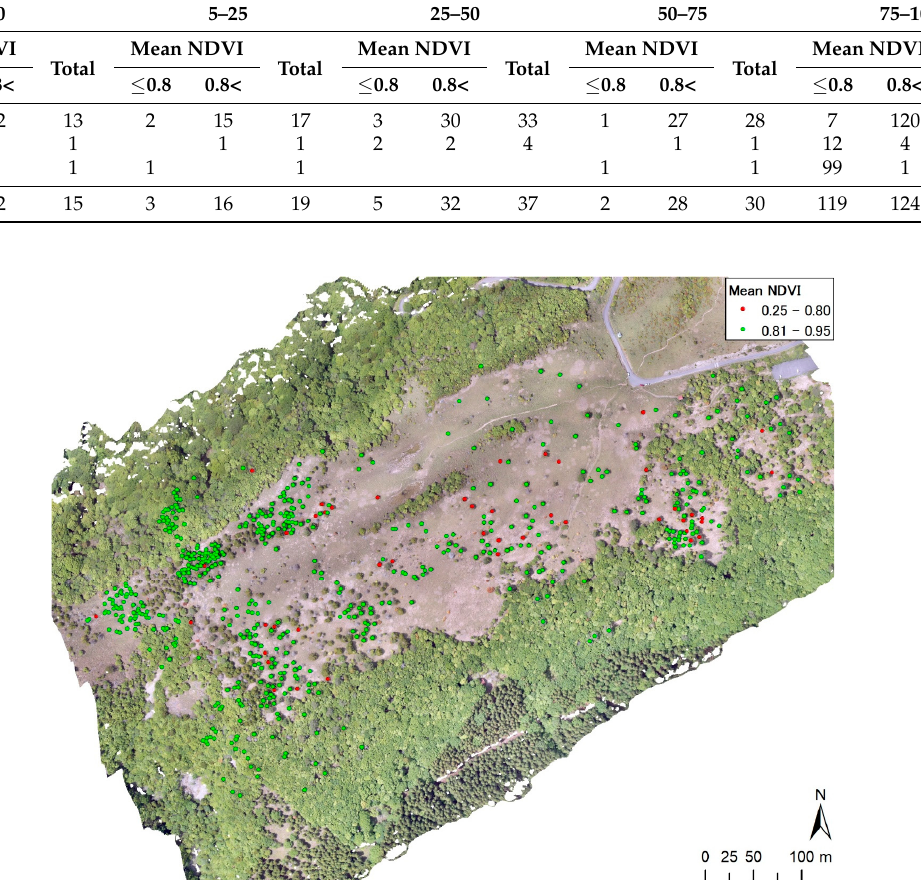
Figure 8. Mean NDVI for A. homolepis not included in the tree-by-tree survey. The threshold values were determined from Figure 7.